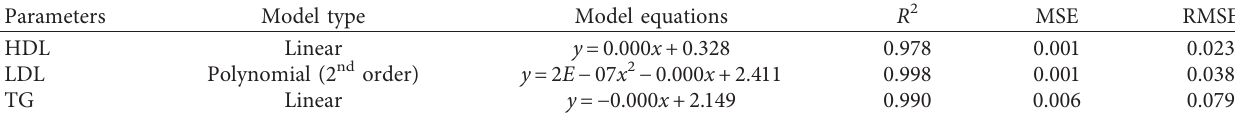
Table 6: Model equations for serum lipid profile